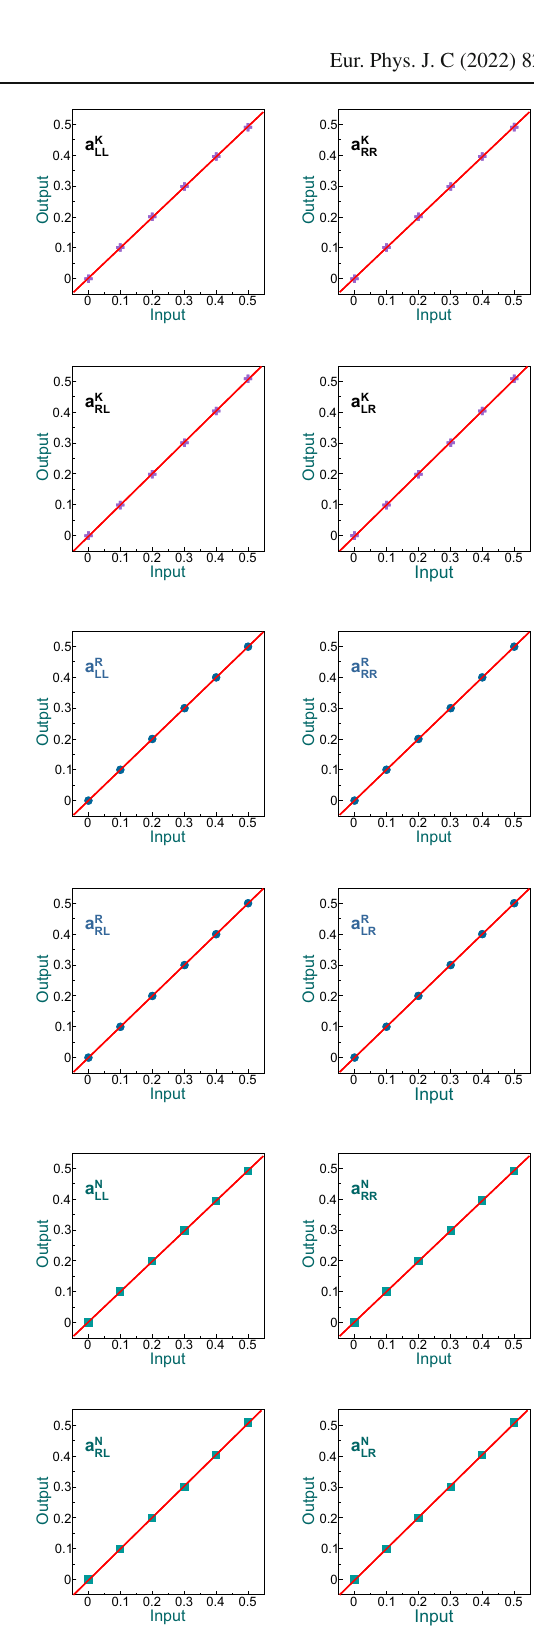
Fig. 3 Linearity tests for mixtures of pure LL , RR , RL and LR polar-